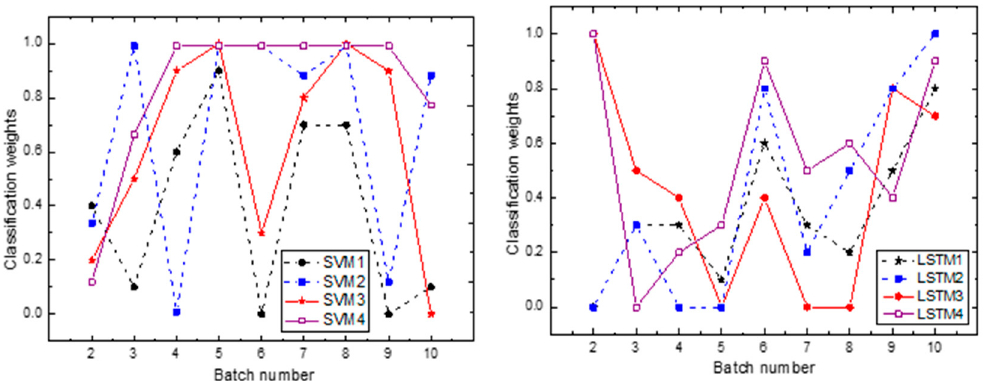
Figure 13. Classifier weights used in the ensembles (SVM1 to SVM4 and, LSTM1 to LSTM4). At every point on the x -axis (batch) the corresponding points in the y -axis are the weights of the individual classifiers used in the ensemble. Note that these weights max up to 1. Note that the dotted indicates that the input is not a classifier for the correlation analysis dataset and, the solid line indicates that the classifier the inputs the data set for correlation analysis.